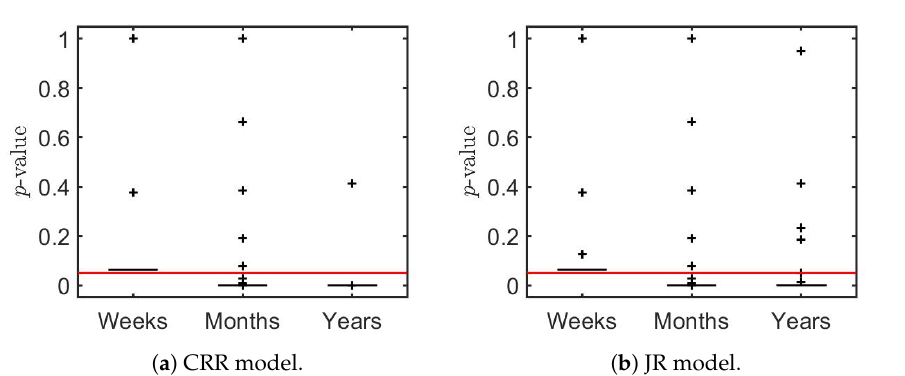
( CRR ) ( JR ) and ˆ p n ∆ t n ∆ t